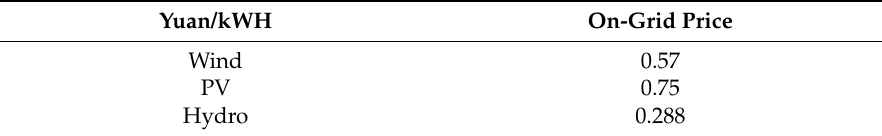
Table 5. The latest published on-grid price in 2018 in Sichuan Province,